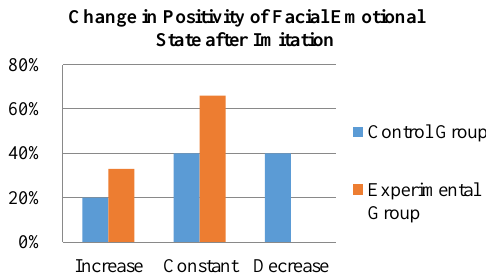
Figure 7. Bar graph comparison of the change in facial emotional state of control and experimental groups after imitation. Participants in the experimental group emoted with the same or increased positivity after imitation. The control group had mixed responses, including a decrease in